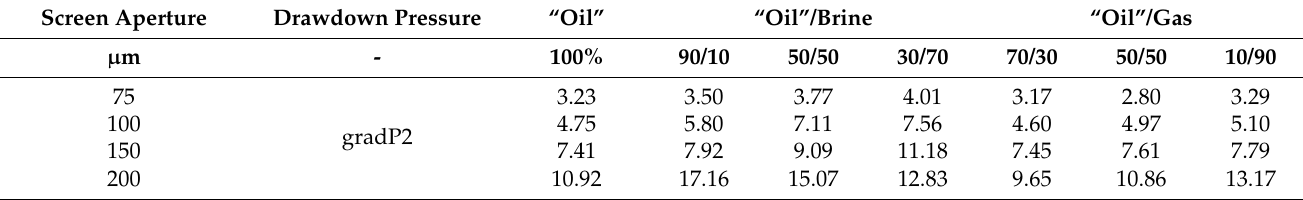
Table 2. Generalized results of filtration tests on bulk with different content of phases in the flow for PSD B (finer)—Suspended solids concentration is presented in